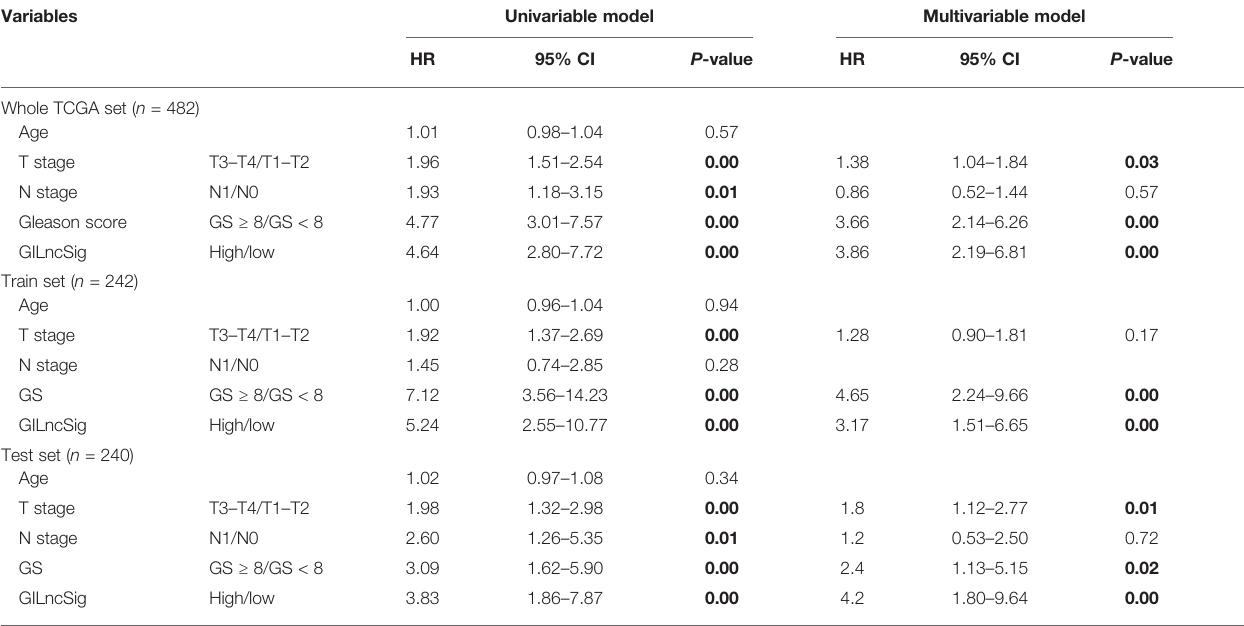
TABLE 2 | Univariate and multivariate Cox regression analyses of the GILncSig and biochemical recurrence in the whole TCGA set, train set, and test set. Variables Univariable model Multivariable